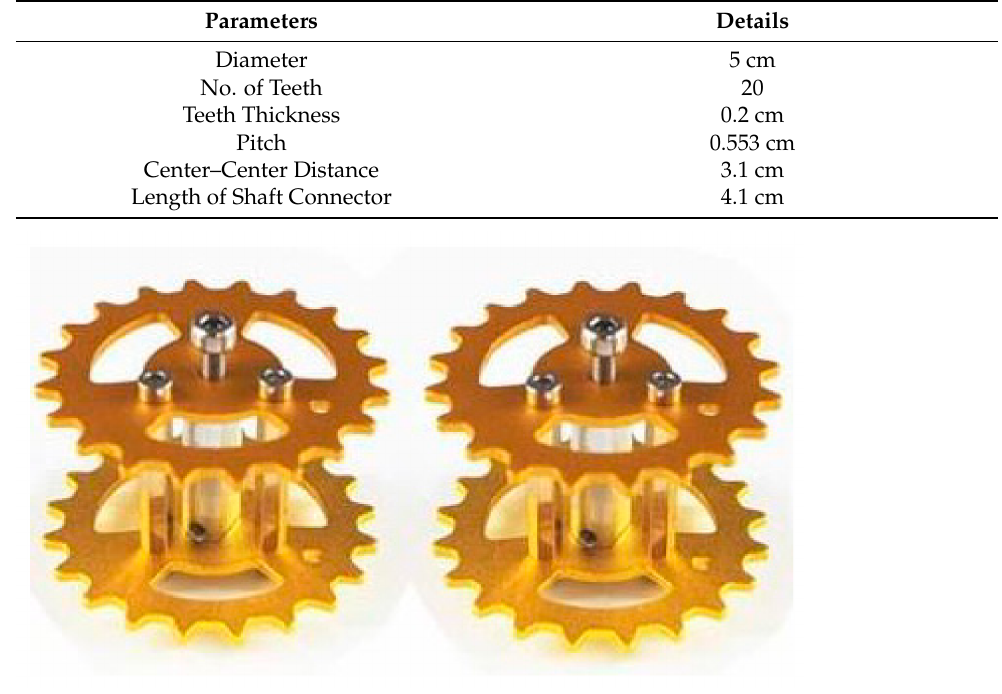
Figure 6. Driving